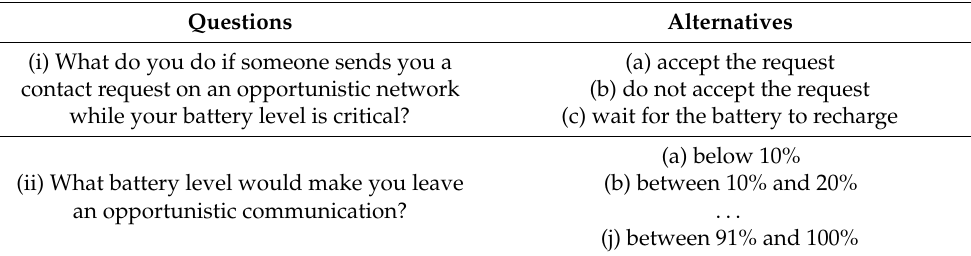
Table 1. Questionnaire about user behavior in usage of their battery of mobile devices in